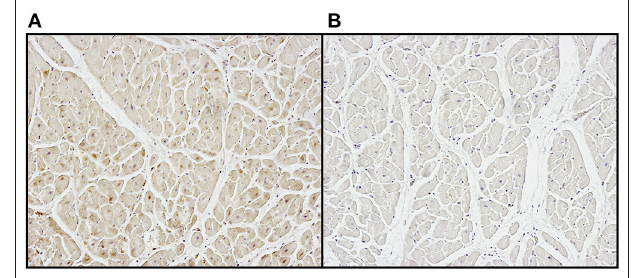
FIGURE 4 | Positive immunostaining (A) to Gram + bacteria in unimplanted commercial bioprosthetic valve tissue compared to (B) negative control.